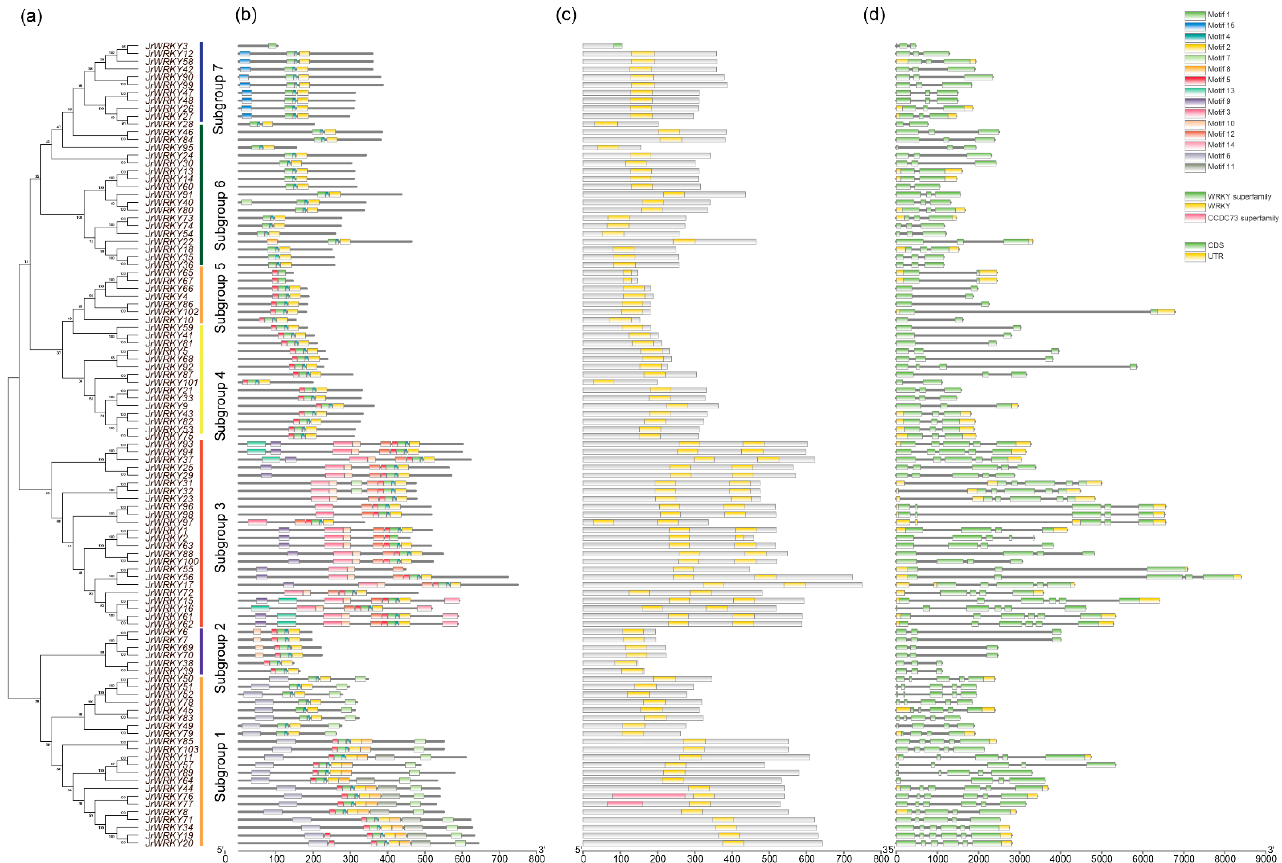
Figure 2. Phylogenetic analyses of the motifs in proteins and gene structures of WRKY genes, ( a ) phylogenetic tree, ( b ) conserved motif distribution of WRKY genes, ( c ) the conserved domains and ( d ) intron-exon distribution of WRKY genes.